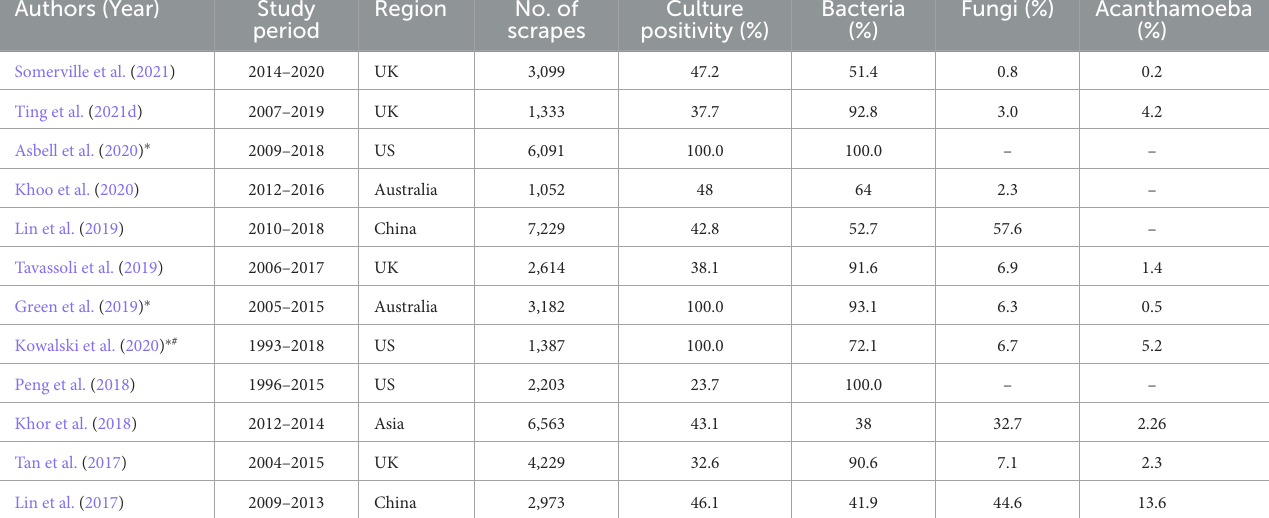
TABLE 2 Summary of large-scale infectious keratitis study ( > 1,000 cases) in the world published between 2016 and 2021, in chronological